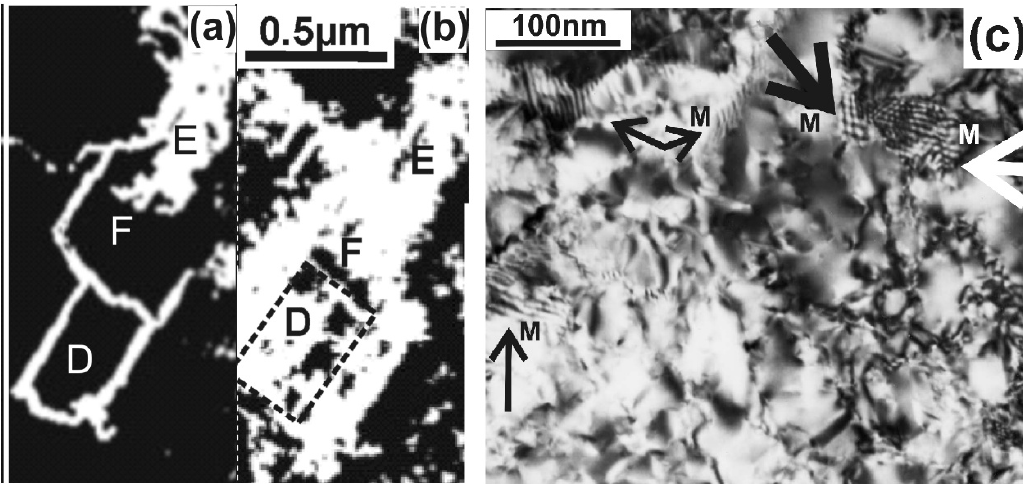
Figure 2. TEM micrographs from in situ Ni-MILC at 520 °C where SPC is significant. ( a ) In the areas D and F, Si whiskers are evident, frequently changing direction, forming a loop in area D. ( b ) The same area 2 min later, the areas D and F are covered by slightly misoriented grains due to SPC. ( c ) Slightly misoriented overlapping grains due to the SPC process give Moiré patterns of rotational type shown by arrows.